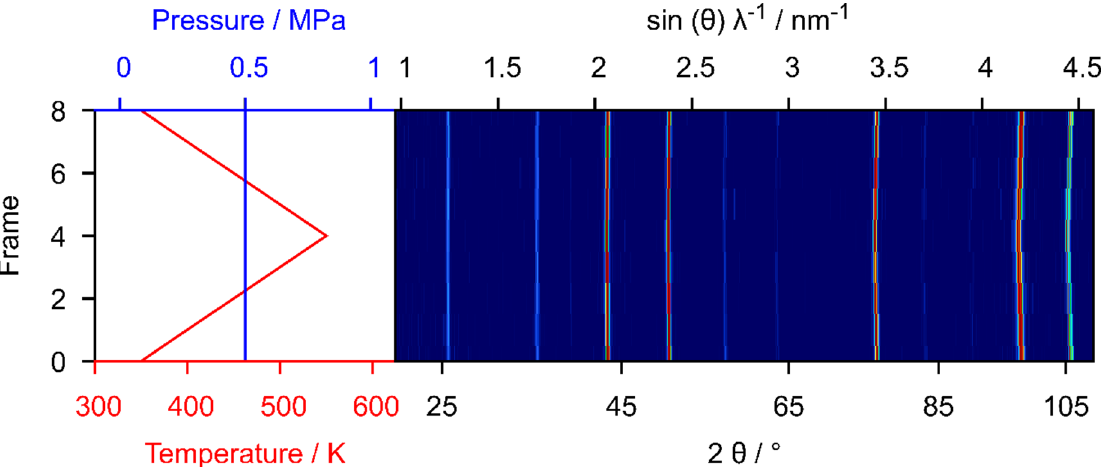
Figure A5. In situ X-ray powder diffraction data of the hydrogenation of ordered FePd 3 (long-time annealed sample) taken with SmartLab diffractometer in an XRK 900 reaction chamber with Co-K α radiation under various temperatures and 0.5 MPa hydrogen pressure. λ 1 is used for sin ( θ ) λ − 1 scale. Intensities are in false colors.